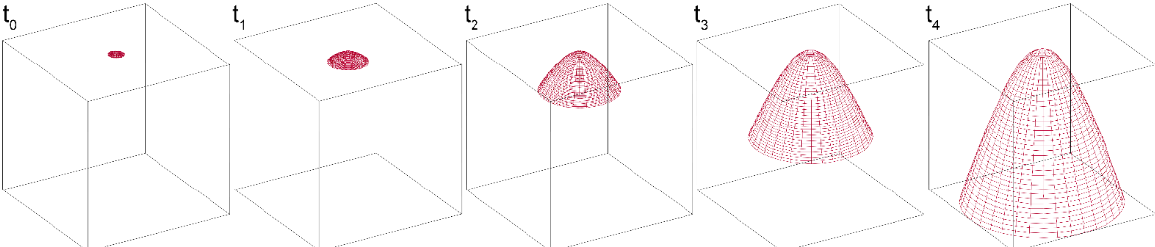
Figure 4. Simulation of 3D trajectory of fluid across the washing layers D1–D3 at various times ( t 0 > t 1 > t 2 > t 3 > t 4 ). The fluid trajectory was described according to a system of parametric equations in polar coordinates (Equation (1)), considering only the direction of the contours of the fluid in each layer. A bell-shaped trajectory is obtained for the fluid front moving across the D layers, characterized by the increasing diameter of the hydrophilic area. This can be ascribed to the combination of a radial movement towards the boundary of the hydrophilic zone of a given D layer and a vertical movement between the adjacent D layers.